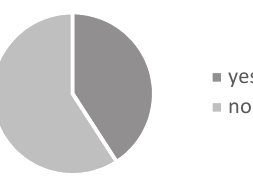
Figure A26. Proportion of the stickers put up indoors, second survey (93 individuals).